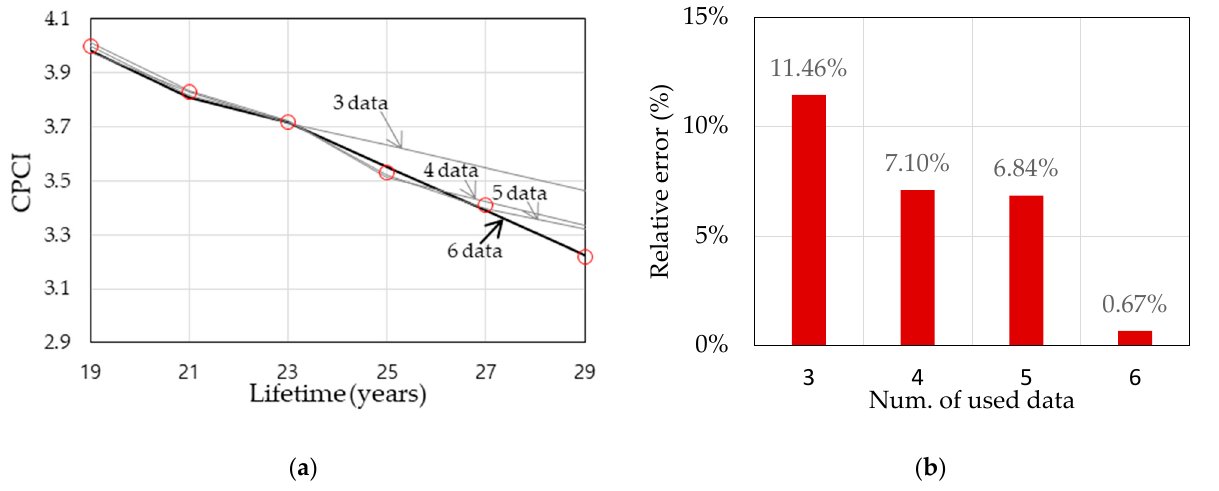
Figure 6. Results of prediction accuracy according to the change in the number of time-series points in the same section. ( a ) Influence of the number of actual data used for updating on the prediction of CPCI by the particle filtering; the lines are the mean values; ( b ) relative errors according to amount of data used for updating.